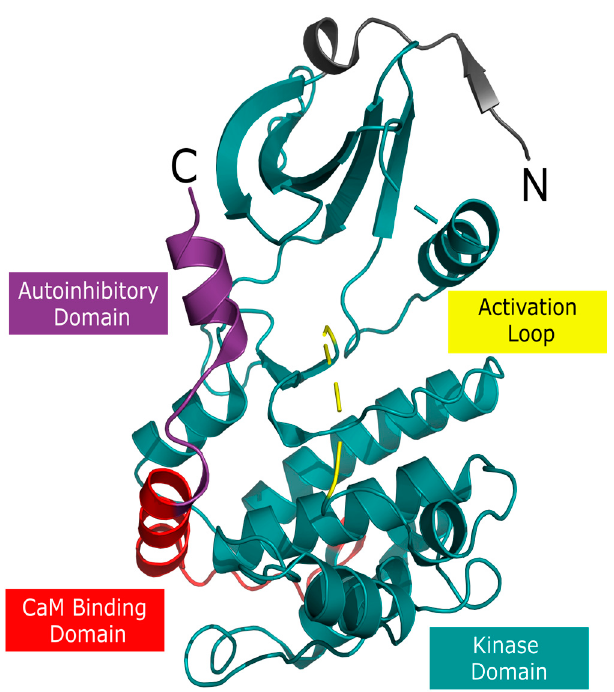
Figure 1. Crystal structure and domains of CaMK1D (PMID: 2JC6). The AID is shown in purple, CaM binding domain in red, activation loop in yellow, and the kinase domain in teal. Elements that do not fall into these categories are shown in grey. The termini are indicated by “N” and “C”.